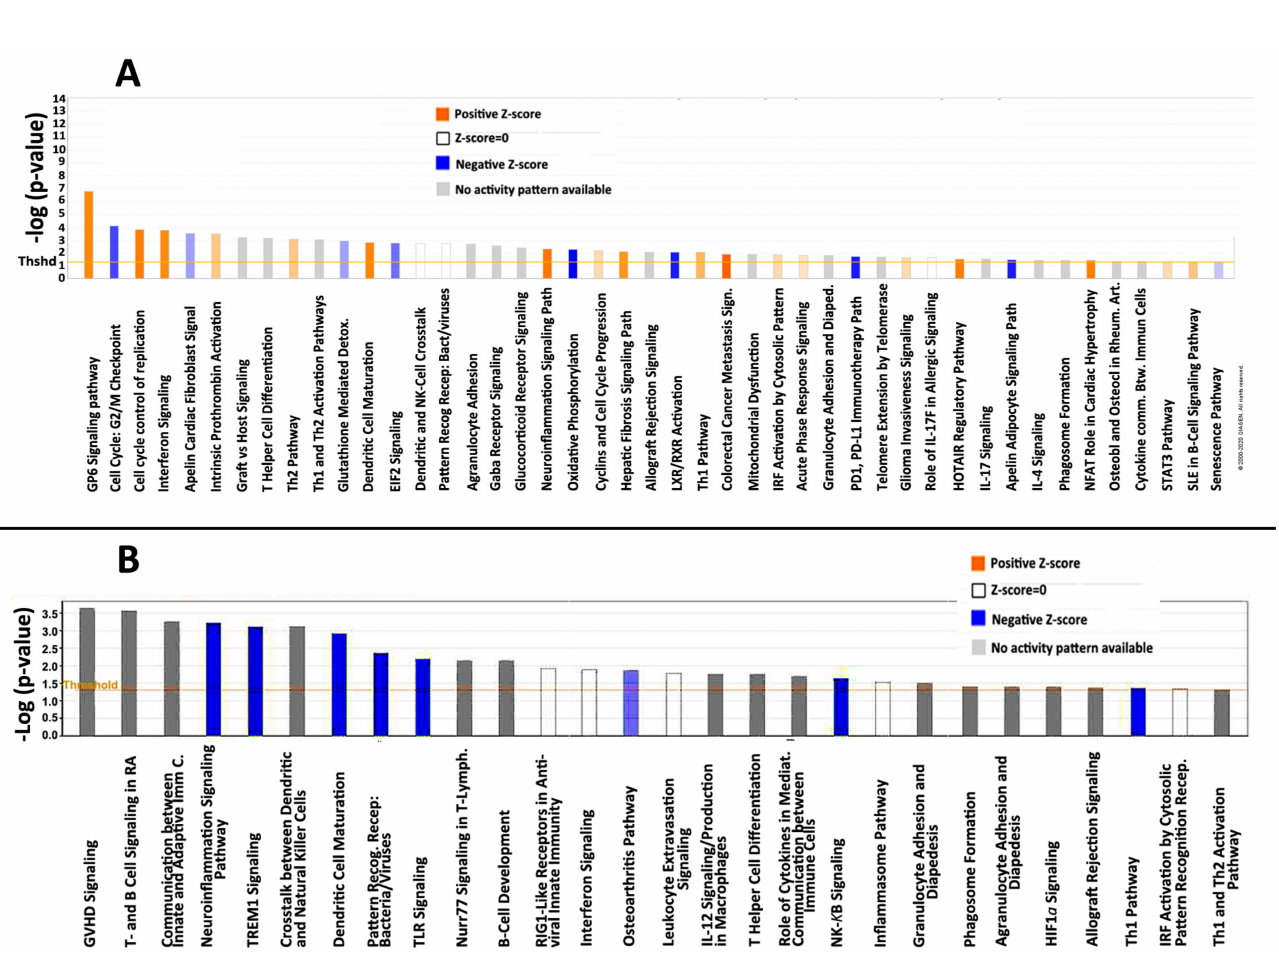
Figure 2. Ingenuity pathway analysis of rAION responses. Pathways evaluated by Ingenuity software package (http: //www.ingenuity.com (accessed on 29 August 2020)). ( A ) Comparison between naïve and rAION-induced, vehicle- injected ONHs. B) Comparison between rAION-induced, vehicle-injected and rAION-induced, PGJ 2 -treated animals. The log p -value response threshold for significance is set at 1.5 fold. Orange signal represents upregulation; blue signal represents downregulation; and white represents equivalent expression levels of pathway members altered both up- and downregulated, while grey signal represents uninterpretable (inconsistent) pathway response. In ( A ), comparison between naïve and vehicle gene sets reveals strong upregulation of interferon-associated pathway signaling, neuroinflammation and dendritic cell maturation pathway signaling, with moderate upregulation of components associated with both the Th1 and Th2 pathways. There is strong downregulation of the G2/M cell cycle checkpoint (=mitotic upregulation), liver-X and retinoic acid (LXR/RXR) pathway components. LXRs are inhibitors of inflammation. In ( B ), following PGJ 2 treatment after rAION, there is suppression of the neuroinflammation, TLR and TREM-macrophage and -neutrophil signaling pathways, as well as suppression of leukocyte extravasation and Th1 signaling, but not Th2. The decrease in NF- κ B signaling confirms PGJ 2 ’s known role in suppression of this